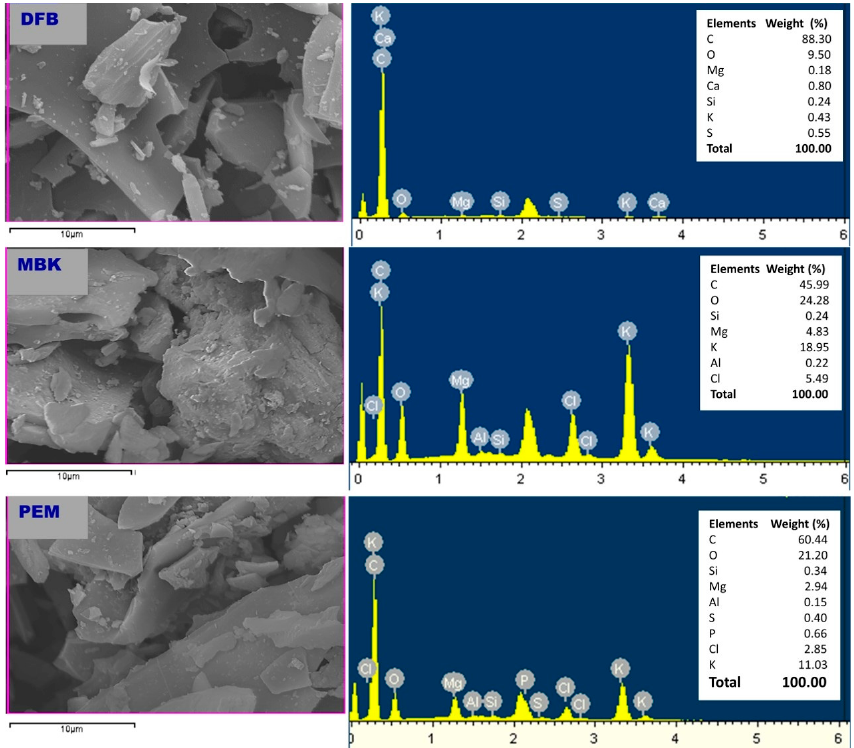
Figure 2. Energy-dispersive X-ray (EDX) spectra of untreated Douglas fir biochar (DFB), DFB treated with MgCl 2 · 6H 2 O + KOH solutions (MKB), and MBK treated with KH 2 PO 4 solution (PEM ).